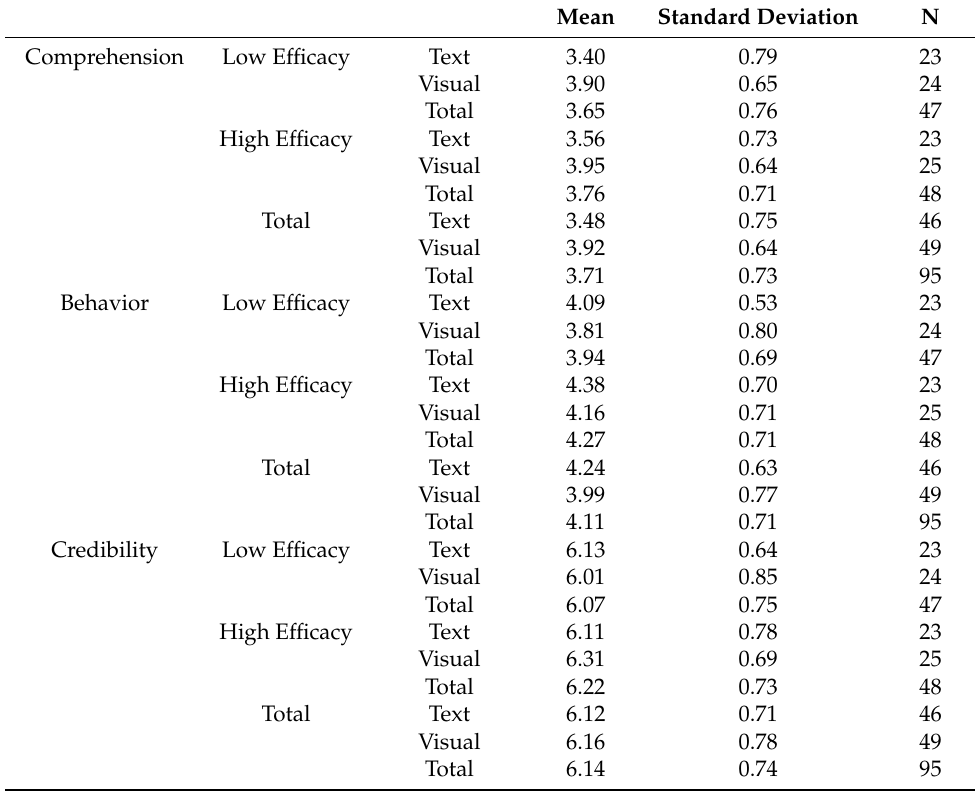
Table 1. Descriptive statistics.